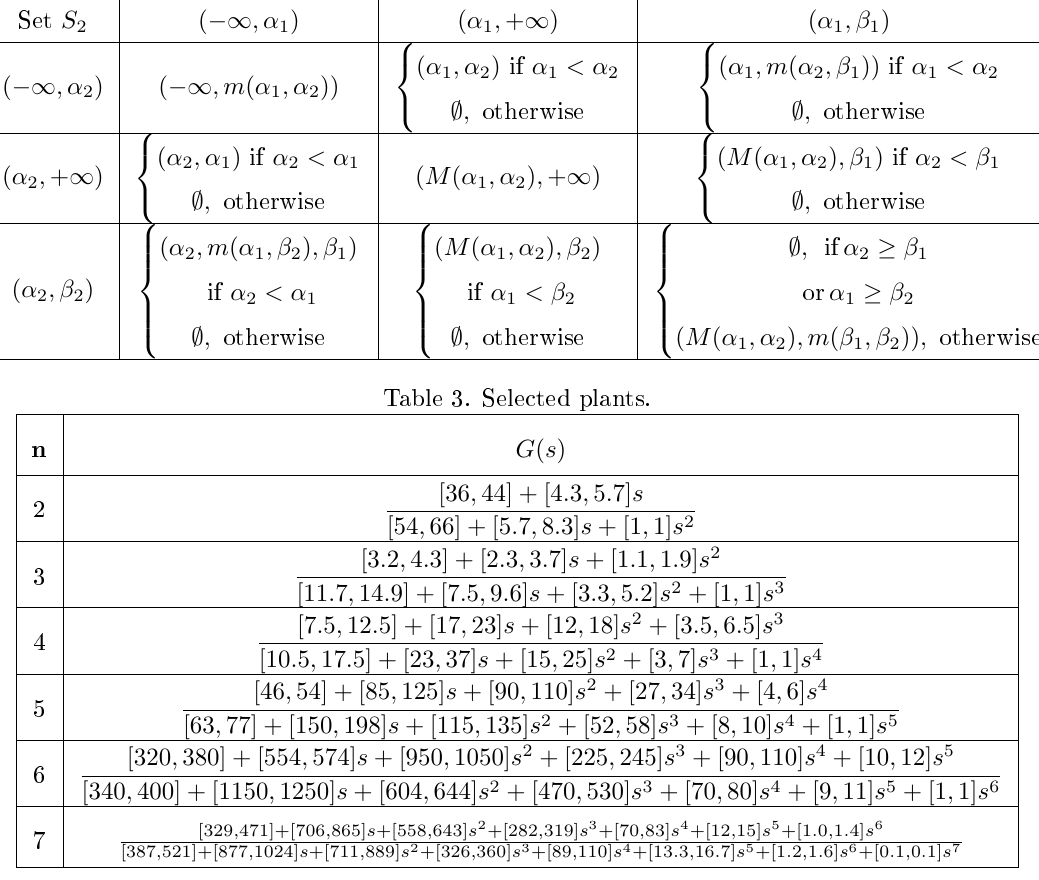
Table 2. Intersection of two sets.